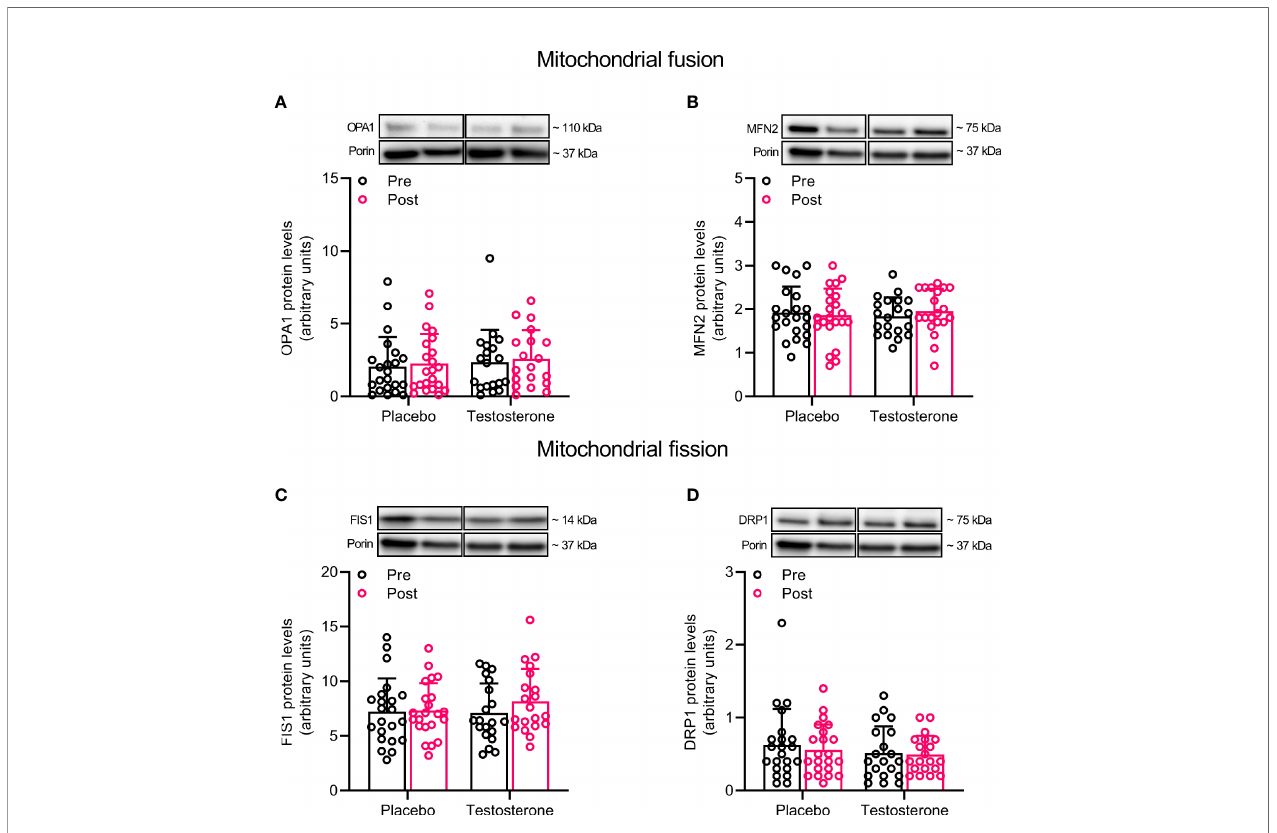
FIGURE 4 | Protein levels of OPA1 (A) , MFN2 (B) , FIS1 (C) , and DRP1 (D) in the mitochondrial fraction before (black dots) and after the intervention (red dots). Representative blots for each individual protein target and Porin are shown above each graph. The values presented are means ± SD and individual data points from 22 and 20 individuals (DF 40) in the placebo group and T group, respectively. For illustrative purposes, one subject from the placebo group displaying extreme values was removed from (A) (pre-post; 6.1 to 19.4), but these values were included in the statistical